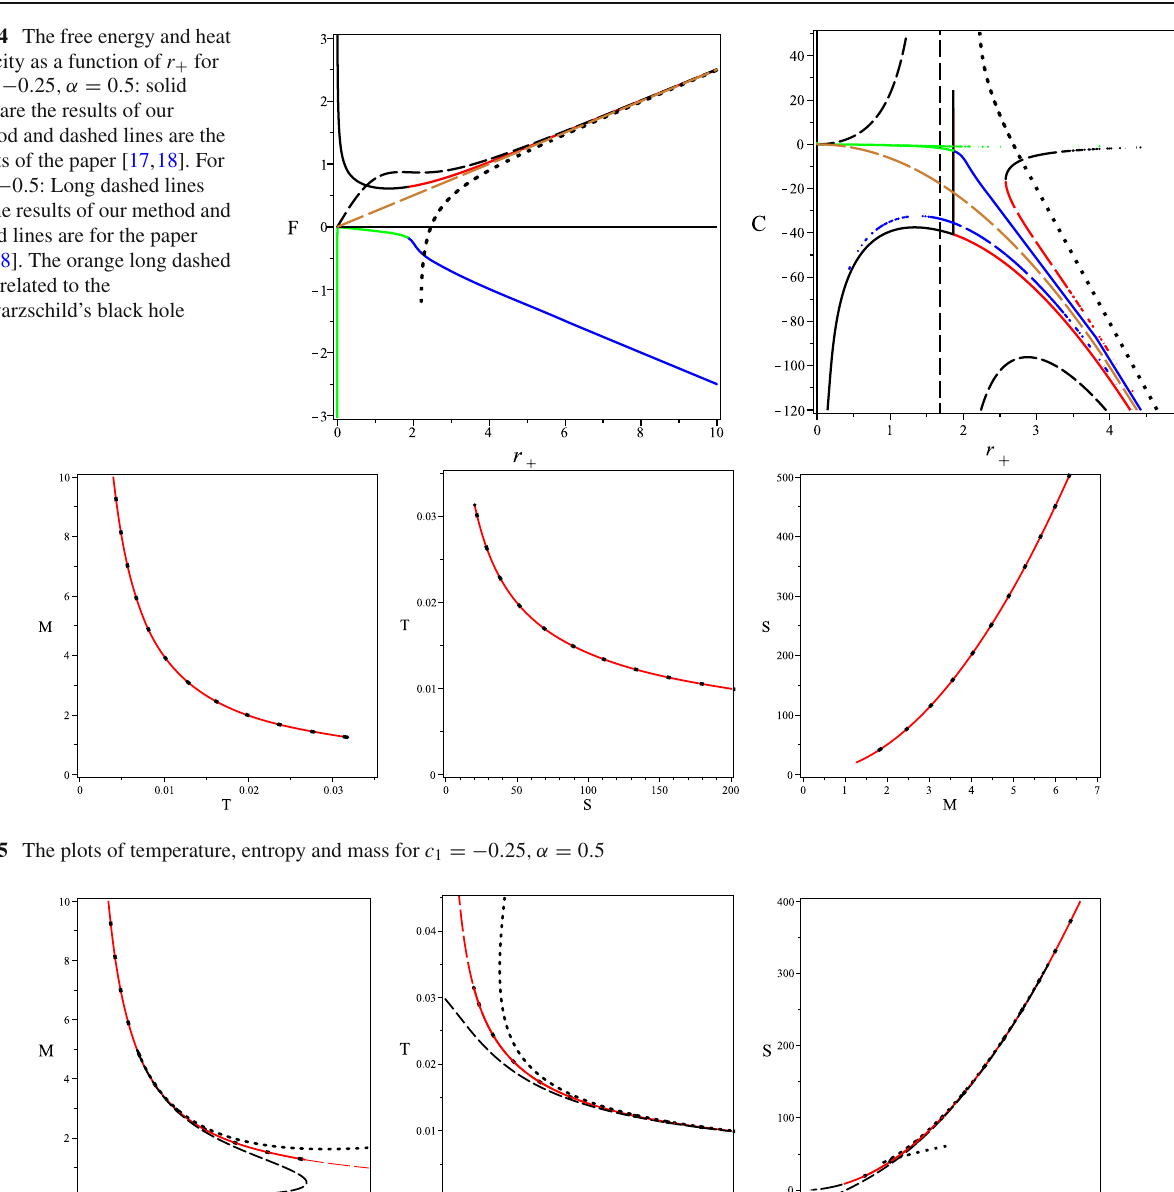
Fig. 4 The free energy and heat capacity as a function of r + for c 1 = − 0 . 25 ,α = 0 . 5: solid lines are the results of our method and dashed lines are the results of the paper [17,18]. For α = − 0 . 5: Long dashed lines are the results of our method and dotted lines are for the paper [17,18]. The orange long dashed lines related to the Schwarzschild’s black hole